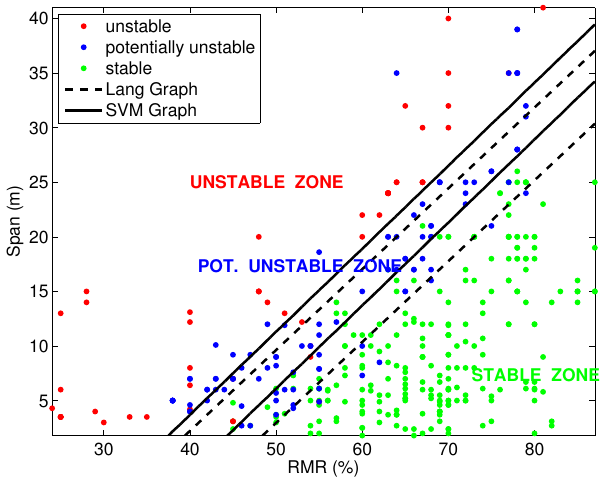
Figure 7. Critical span graph: comparison SVM (probabilistic binary) vs.